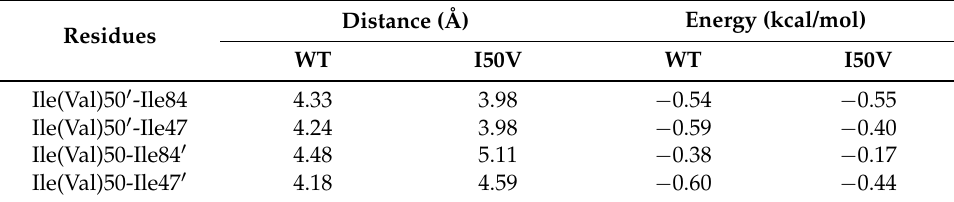
Table 4. The distances and energies between residues 50 and 84/47.